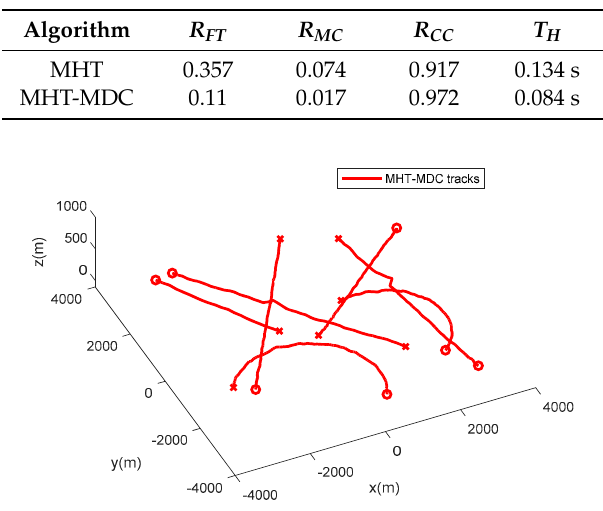
Figure 7. The estimated trajectories of the multiple hypothesis tracker using validation gate with motion direction constraint (MHT-MDC) in scenario 1.